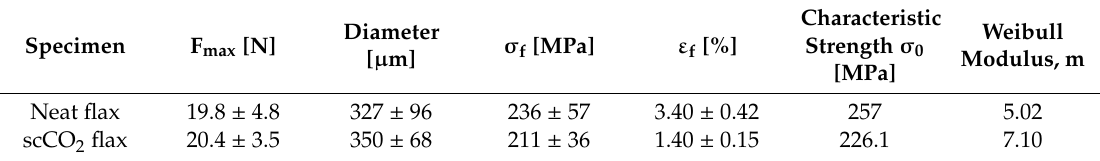
Table 3. Tensile properties of untreated and scCO 2 treated flax yarns and the corresponding Weibull